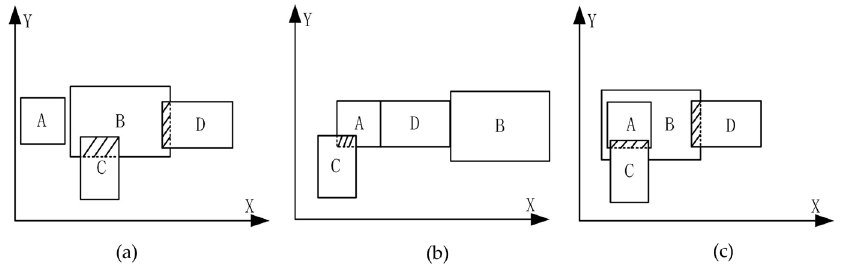
Figure 22. Principle of the collision detection algorithm: ( a ) Status one; ( b ) Status two; ( c ) Status three.